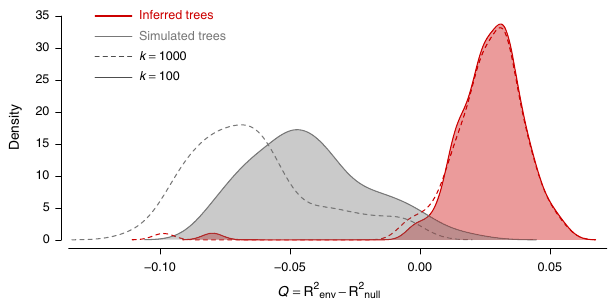
Fig. 4 Impact of annual mean temperature acting as a conductance factor on the dispersal velocity of viral lineages. The graph displays the distribution of the correlation metric Q computed on 100 spatially annotated trees obtained by continuous phylogeographic inference (red distributions). The metric Q measures to what extent considering a heterogeneous environmental raster, increases the correlation between lineage durations and environmentally scaled distances compared to a homogeneous raster. If Q is positive and supported, it indicates that the heterogeneity in lineage dispersal velocity can be at least partially explained by the environmental factor under investigation. The graph also displays the distribution of Q values computed on the same 100 posterior trees along which we simulated a new forward-in- time diffusion process (grey distributions). These simulations are used as a null dispersal model to estimate the support associated with the inferred distribution of Q values. For both inferred and simulated trees, we report the Q distributions obtained while transforming the original environmental raster according to two different scaling parameter k values (100 and 1000; respectively full and dashed line, see the text for further details on this transformation). The annual mean temperature raster, transformed in conductance values using these two k values, is the only environmental factor for which we detect a positive distribution of Q that is also associated with a strong statistical support (Bayes